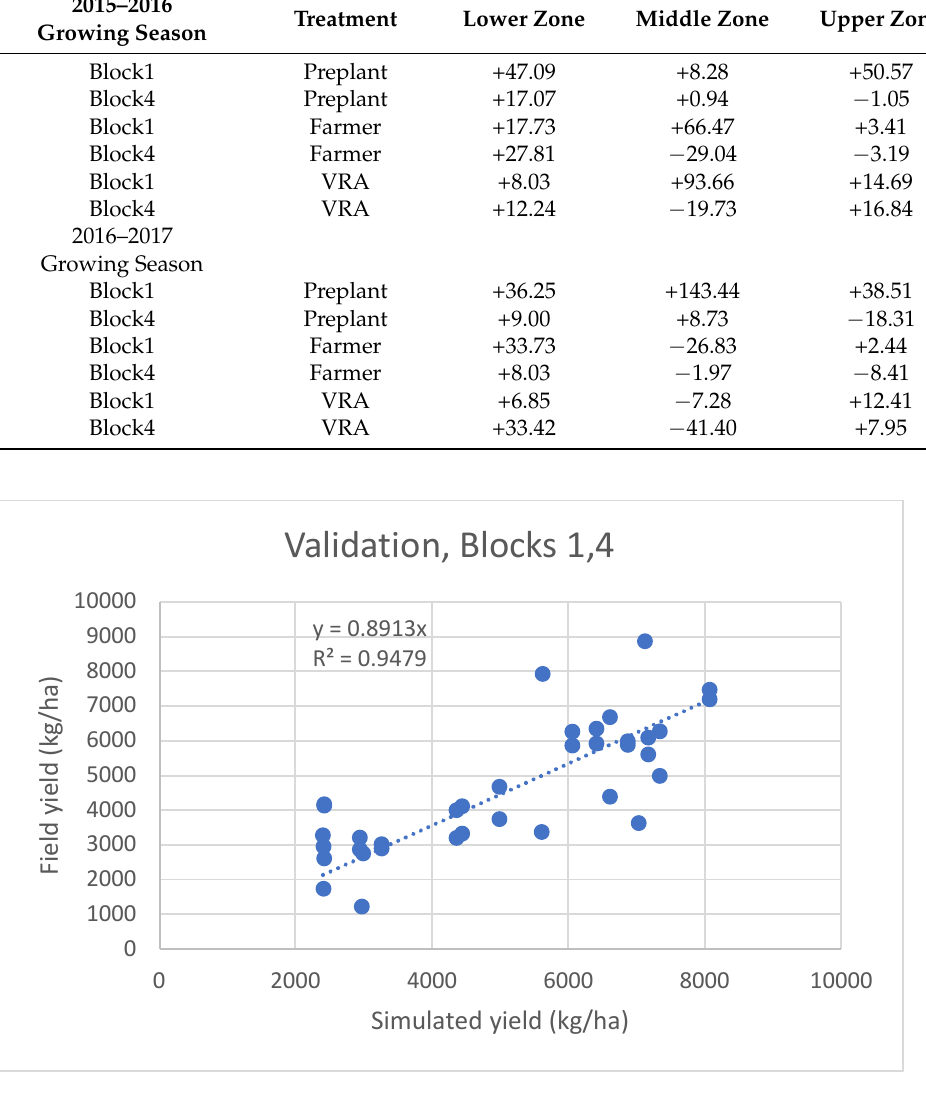
Table 8. Relative variation in simulated final yield.